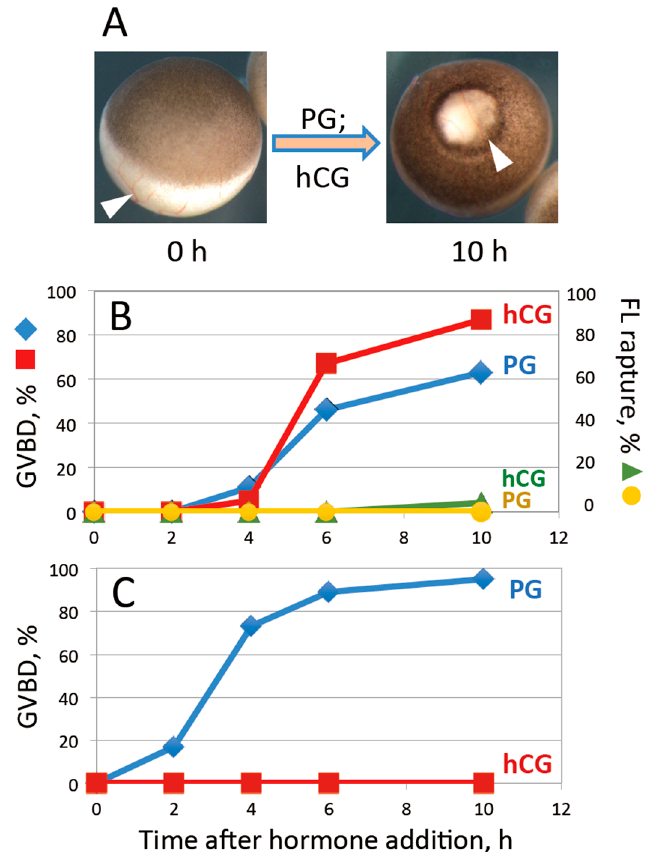
Figure 1. Effects of progesterone (PG) and human chorionic gonadotropin (hCG) on Xenopus follicular oocytes in vitro. ( A ) Morphology of isolated stage VI follicles before and after hormonal treatment. The white arrowheads in the panel point to the thin blood capillaries visible in the follicle layer. ( B ) Time course of germinal vesicle breakdown (GVBD) and follicle rupture in the hormone-treated oocytes. ( C ) Effects of the ovulation hormones on defolliculated oocytes. To remove the follicle layer, oocytes were treated with 5 mg/mL collagenase for 3 h before hormone administration. The experiment was repeated with five batches of follicular oocytes obtained from different animals. The results of a single batch experiment are presented in the figure.